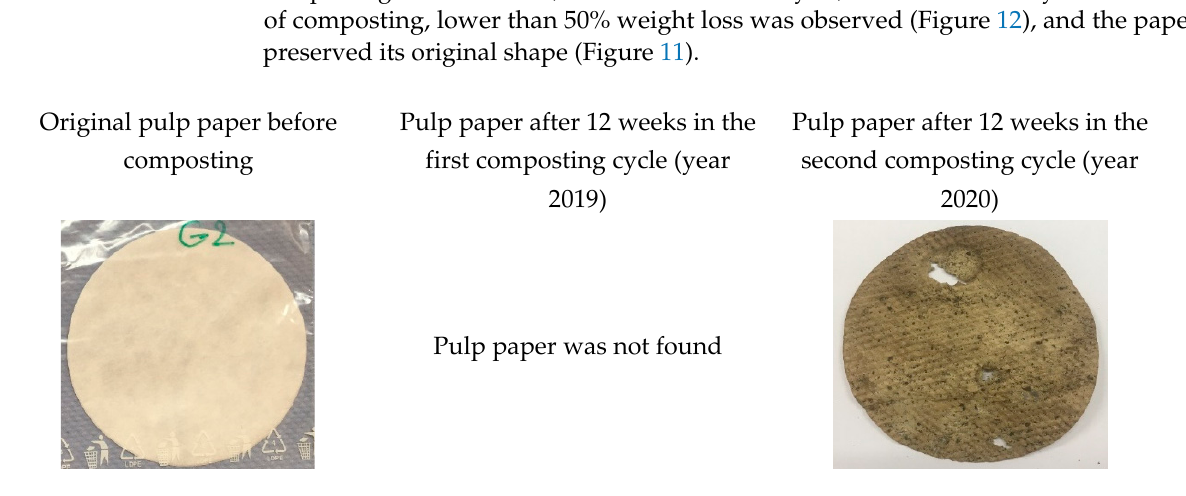
Figure 11. Pulp paper reference material before industrial composting and after 12 weeks of composting.